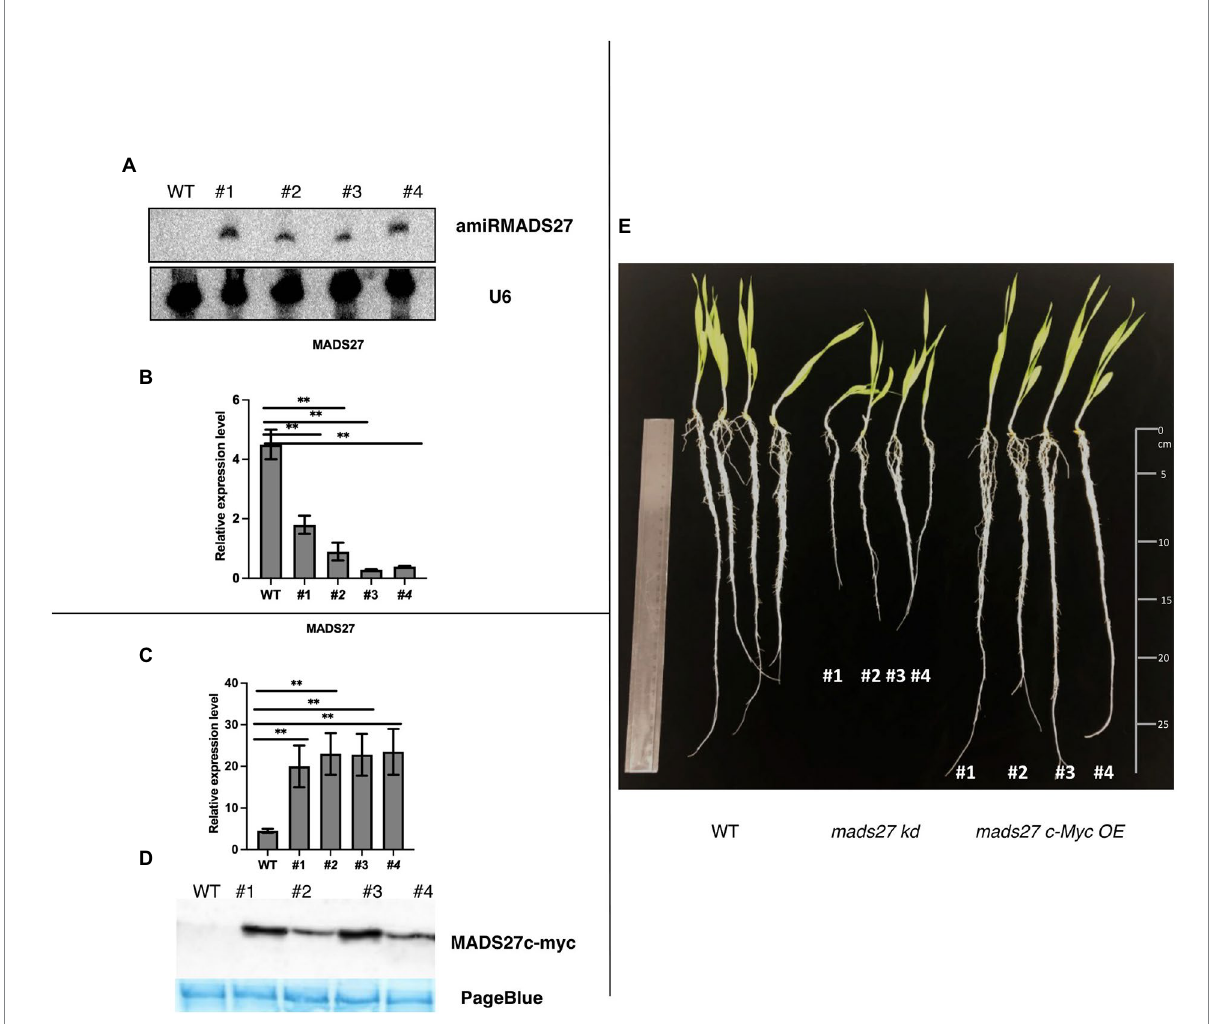
FIGURE 2 Characterization of hvmads27 knockdown and overexpressing transgenic plants. (A) Northern blot analysis depicting the presence of amiRNAMADS27 in mads27 kd mutant lines using material from WT roots as control and U6 snRNA as loading control. (B) RT-qPCR analysis showing HvMADS27 mRNA expression in mads27 kd mutant lines compared with WT plants relative to ARF 1 mRNA level (Gene Bank: AJ508228.2), x -axis represents the transgenic lines and y -axis represents relative expression of mRNA. (C) RT-qPCR analysis showing HvMADS27 mRNA expression in transgenic lines overexpressing HvMADS27 with c-Myc tag relative to ARF 1 mRNA level (Gene Bank: AJ508228.2); x -axis represents the transgenic lines and y -axis represents relative expression of HvMADS27 mRNA. (D) Western blot experiment showing expression of HvMADS27 protein with c-Myc tag; lower panel showing loading control—PageBlue staining (E) 2-week old barley plants: WT plant, mads27 kd , and mads27 c-Myc OE mutants, respectively; mads27 kd plants exhibited short roots compared with the other transgenic lines. (A–E) #1, #2, #3, and #4 represent mads27 kd , mads27 c-Myc OE plants from four independent transgenic lines, respectively. p value was based on standard Student’s t -test ** p <